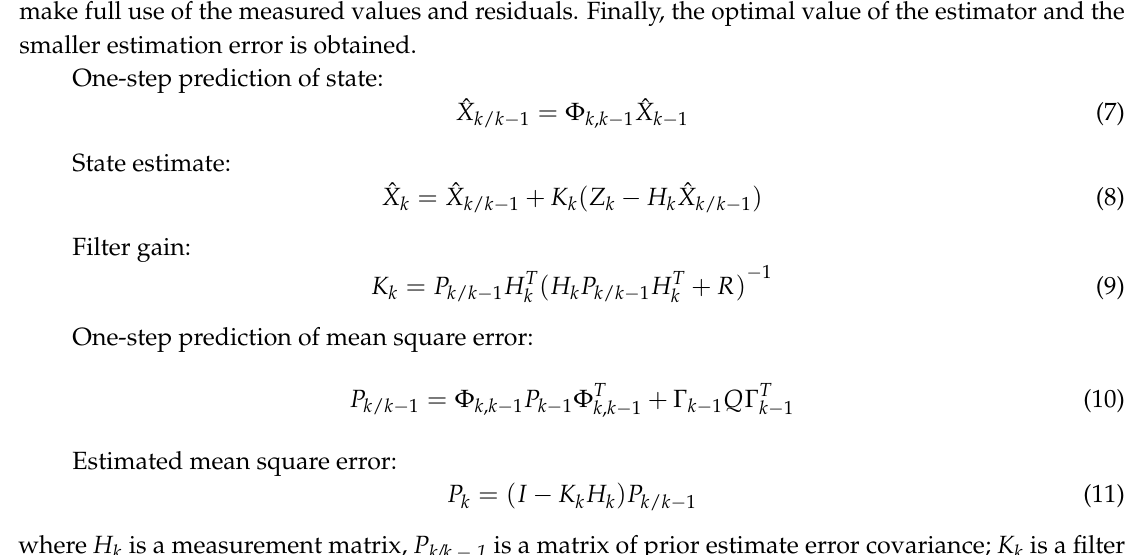
GA + KF fusion algorithm is established. The algorithm is online in real-time and also has certain learning abilities. Combined with the temperature drift model, the RBF NN + GA + KF temperature compensation model fusion algorithm is determined. The flow chart of the fusion algorithm is shown in Figure